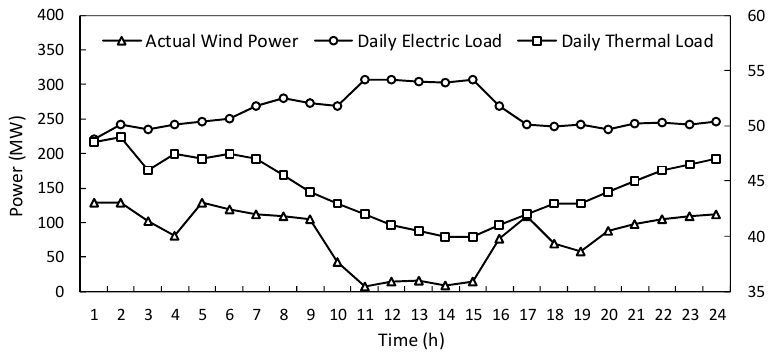
Figure 5. Daily profile for wind power, electric and thermal loads.